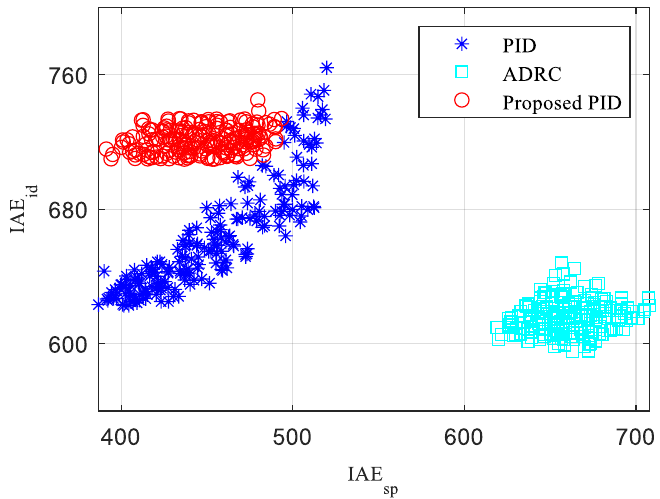
Figure 15. IAE sp and IAE id distribution under an operating condition of 75% load.